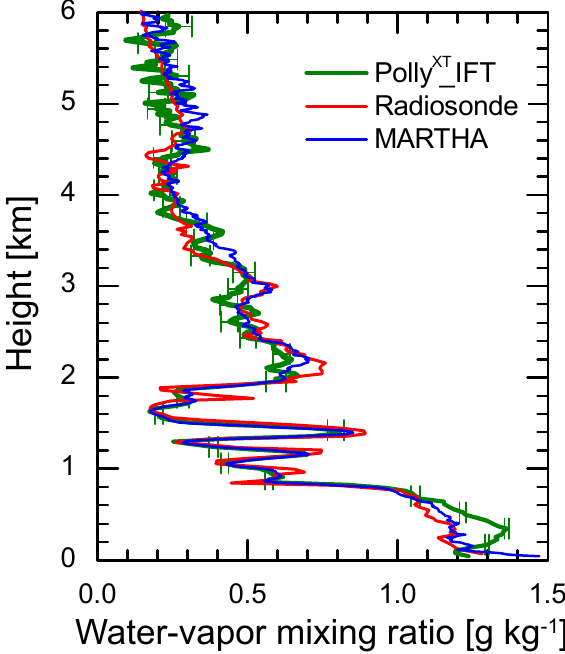
Figure 8. 90min mean profiles of the water-vapor mixing ratio as determined with Polly XT _IFT (green, 30m vertical smoothing up to 2km height, 60m above), a co-located radiosonde (red), and co- incident measurements of the EARLINET Raman lidar MARTHA (blue, resolution 30m) at Leipzig on 10 February 2012 (19:00– 20:30UTC). The error bars are calculated from the signal